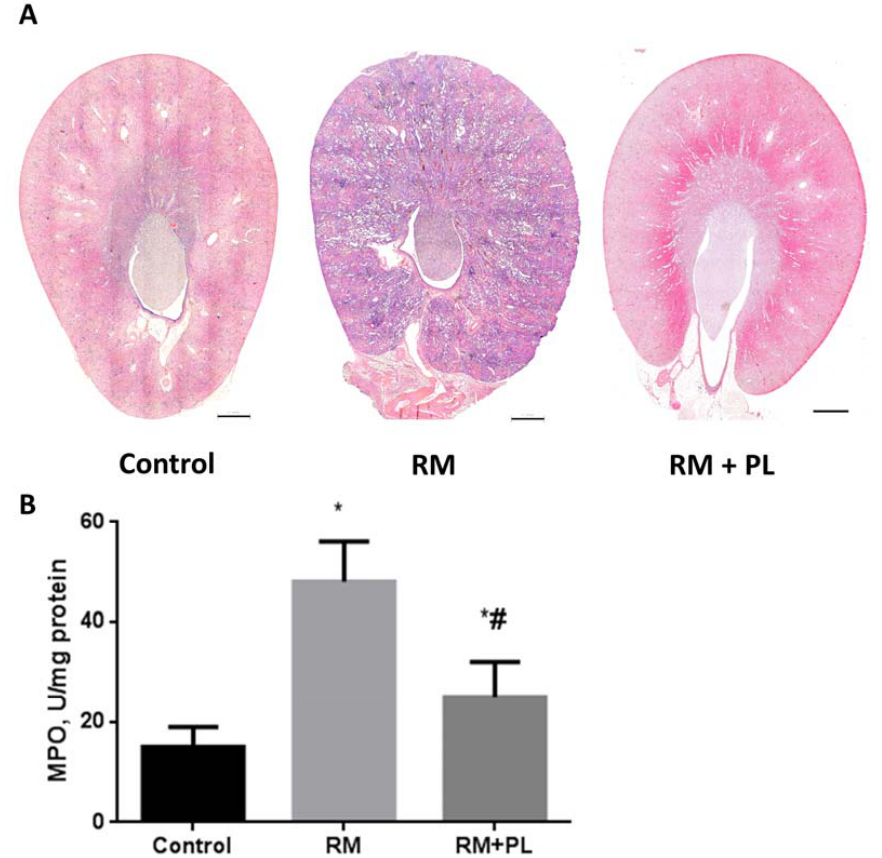
Figure 3. Leukocyte infiltration in the kidney after rhabdomyolysis. ( A ) Panoramic images of transverse sections of the kidneys in the control, rhabdomyolysis (RM), and rhabdomyolysis with PL treatment (RM + PL). Intensive hematoxylin staining of the renal tissue was observed after rhabdomyolysis due to a significantly increased number of nuclei in the infiltrated cell; the PL ‐ group resembled the control. Scale bar, 1 mm. ( B ) Activity of MPO in the kidney tissue during rhabdomyolysis and PL administration. * p < 0.05 compared to control, # p < 0.05 compared to RM.